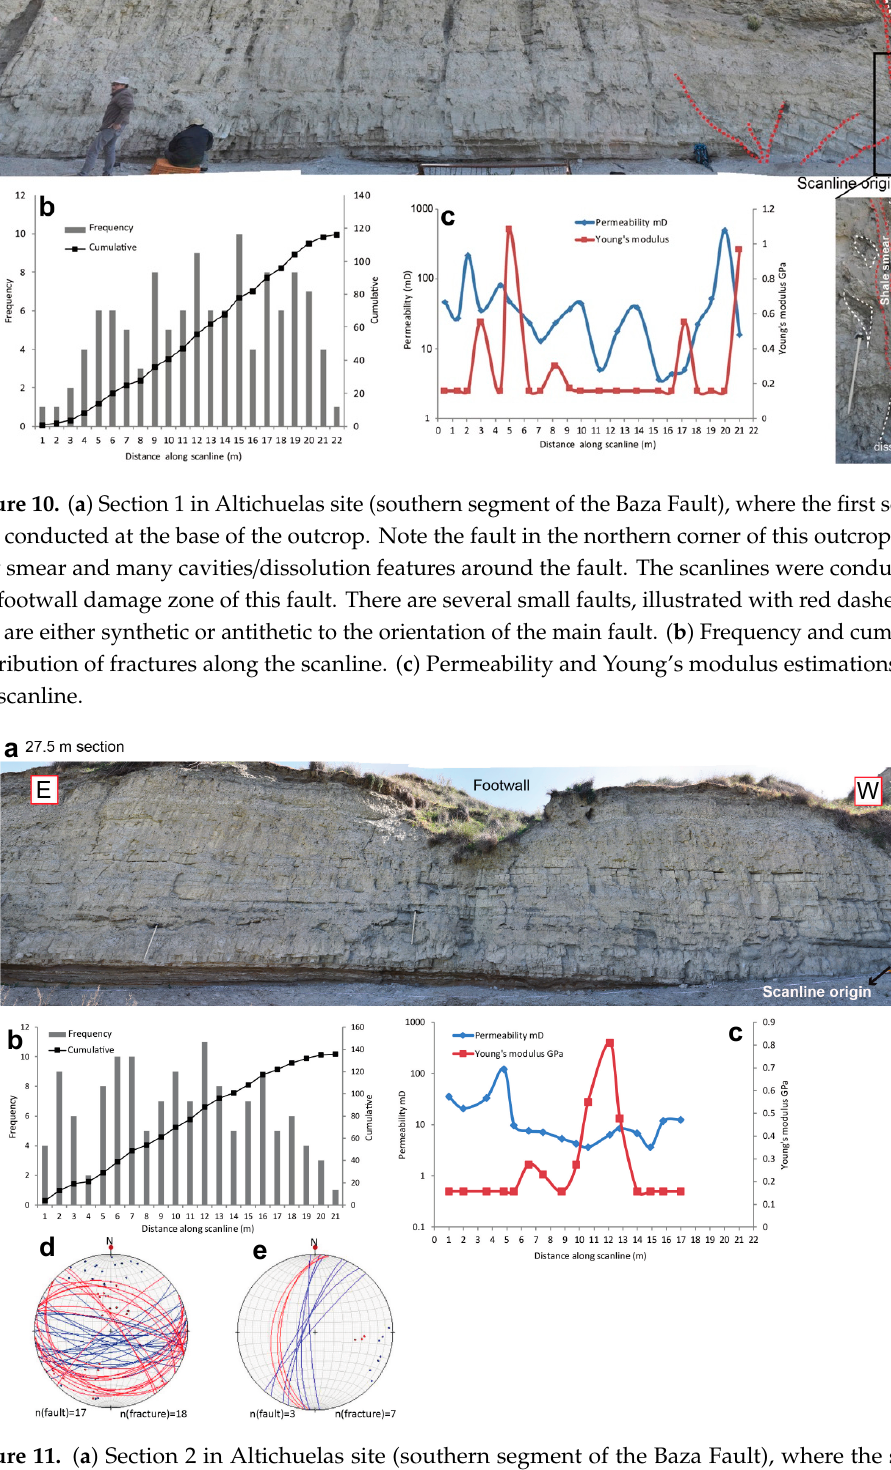
Figure 11. ( a ) Section 2 in Altichuelas site (southern segment of the Baza Fault), where the second scanline was conducted at the base of the outcrop. Note that there are only fractures observed in this section, which is part of the main fault footwall damage zone. ( b ) Frequency and cumulative distribution of fractures along the scanline. ( c ) Permeability and Young’s modulus estimations along the scanline. ( d ) and ( e ) stereoplots of faults (red) and fractures (blue) in Sections 1 and 2, respectively.